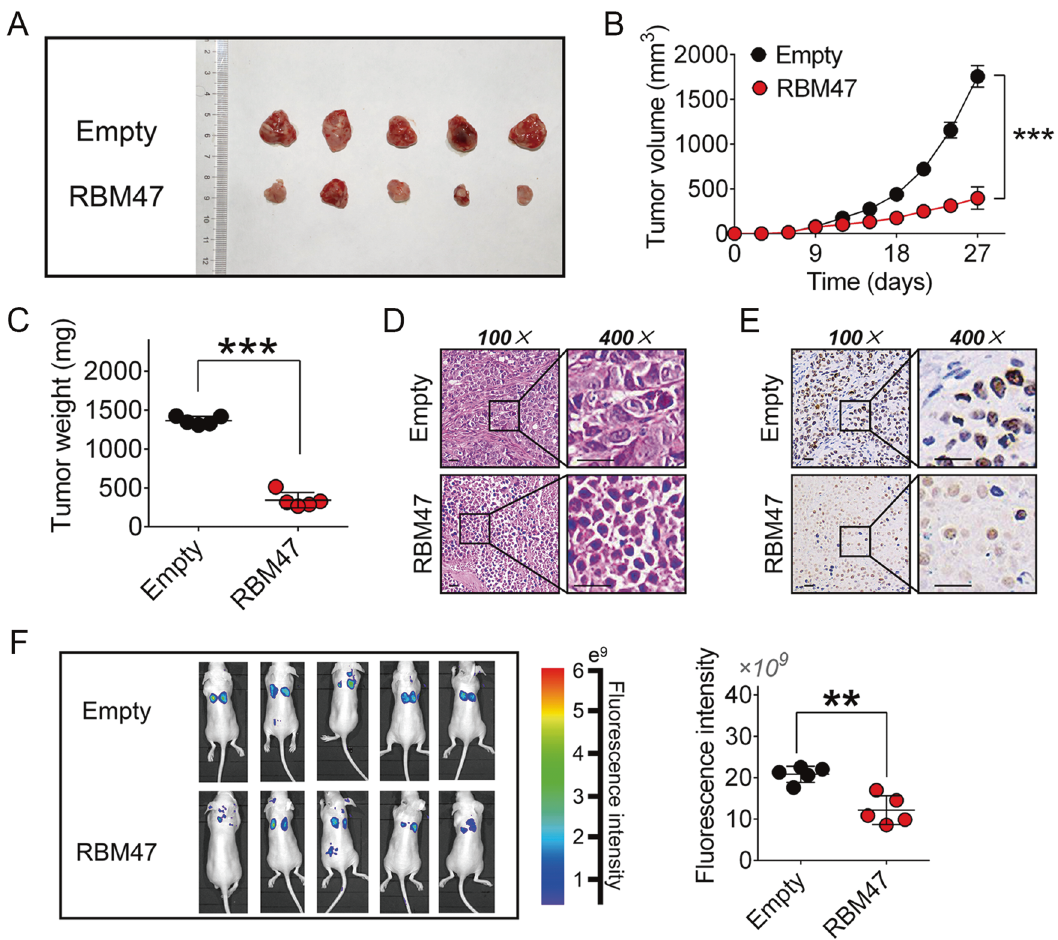
Fig. 2 RBM47 inhibits tumor growth and metastasis in vivo. A Representative images of removed subcutaneously implanted tumors. B The effects of RBM47 on tumor growth are summarized by a tumor growth curve. Error bars are SD ( n = 5). C Comparison of tumor weight between the RBM47 overexpression group and the control group. Error bars are SD ( n = 5). Microscopic images of HE ( D ) and immunohistochemical staining patterns for Ki-67 ( E ) in tumor xenografts from the nude mice in the RBM47 overexpression group and the control group (scale bars = 50 μ m). F Observation of lung metastasis by in vivo imaging after tail vein injection with cells stably transfected with RBM47 or empty vector with fl uorescence labeling (left panel) and quantitative analysis of fl uorescence intensity (right panel). Error bars are SD ( n = 5). ** P < 0.01, *** P <